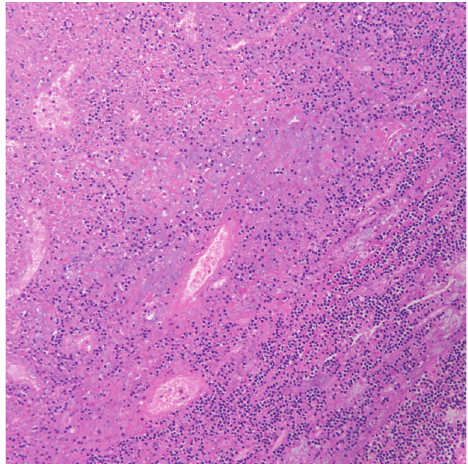
Figure 3: Distribution of necrotic foci (mottled tissue) and mononuclear cells in the paracortical region of a lymph node (Hematoxylin-eosin stain, original magnification × 10.).